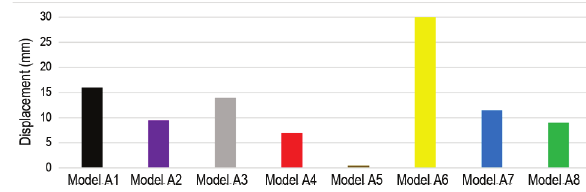
Fig. 10. Comparison chart of maximum relative displacement for eight laminated glass models